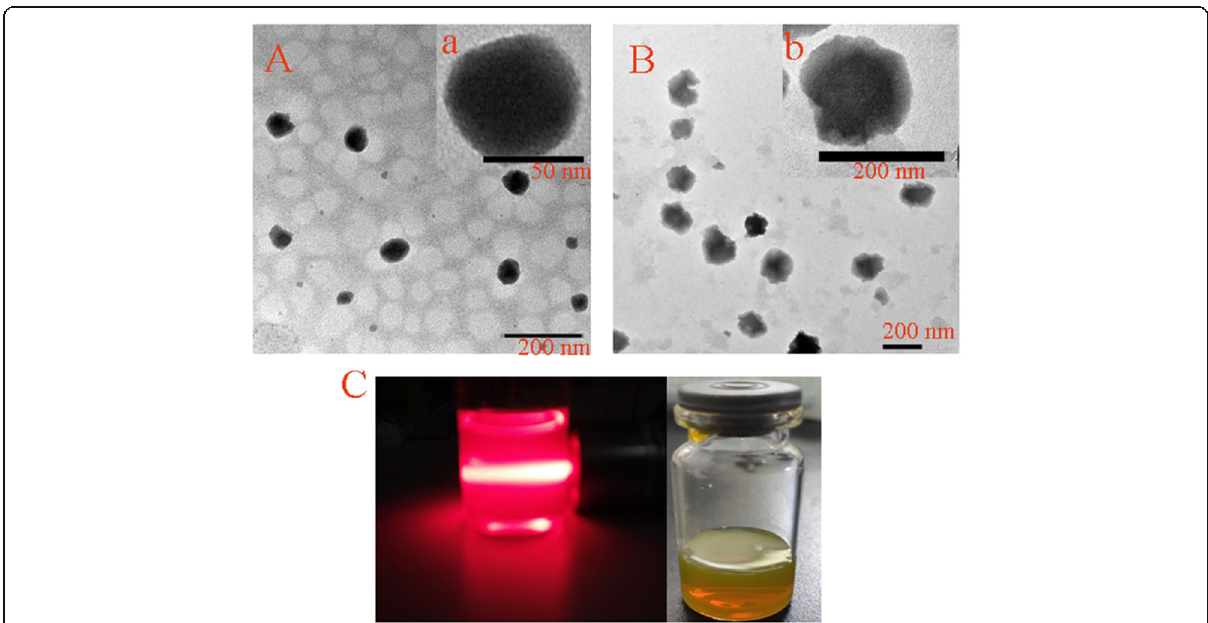
Fig. 4 A The TEM images of CUR-BCSCs and a single CUR-BCSC. B The TEM images of CUR-BCSC@PCs and a single CUR-BCSC@PC. C Tyndall effect and the photograph of CUR-BCSC@PCs in water